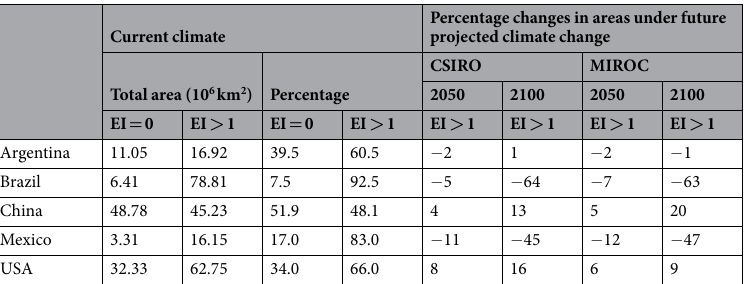
USA. Figure 4 indicates the percentage of suitable areas for maize cultivation under the current scenario for the major five maize producers. The future scenarios indicate increases or decreases in this area for the major groups in relation to the current scenario. Changes in areas of climatic suitability for maize among the current five major maize producers. For example,